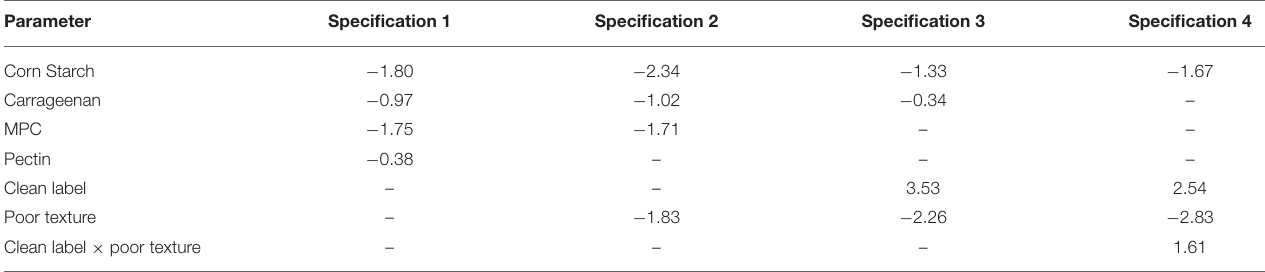
TABLE 4 | Alternative-specific mixed logit specifications, willingness to pay estimates for significant